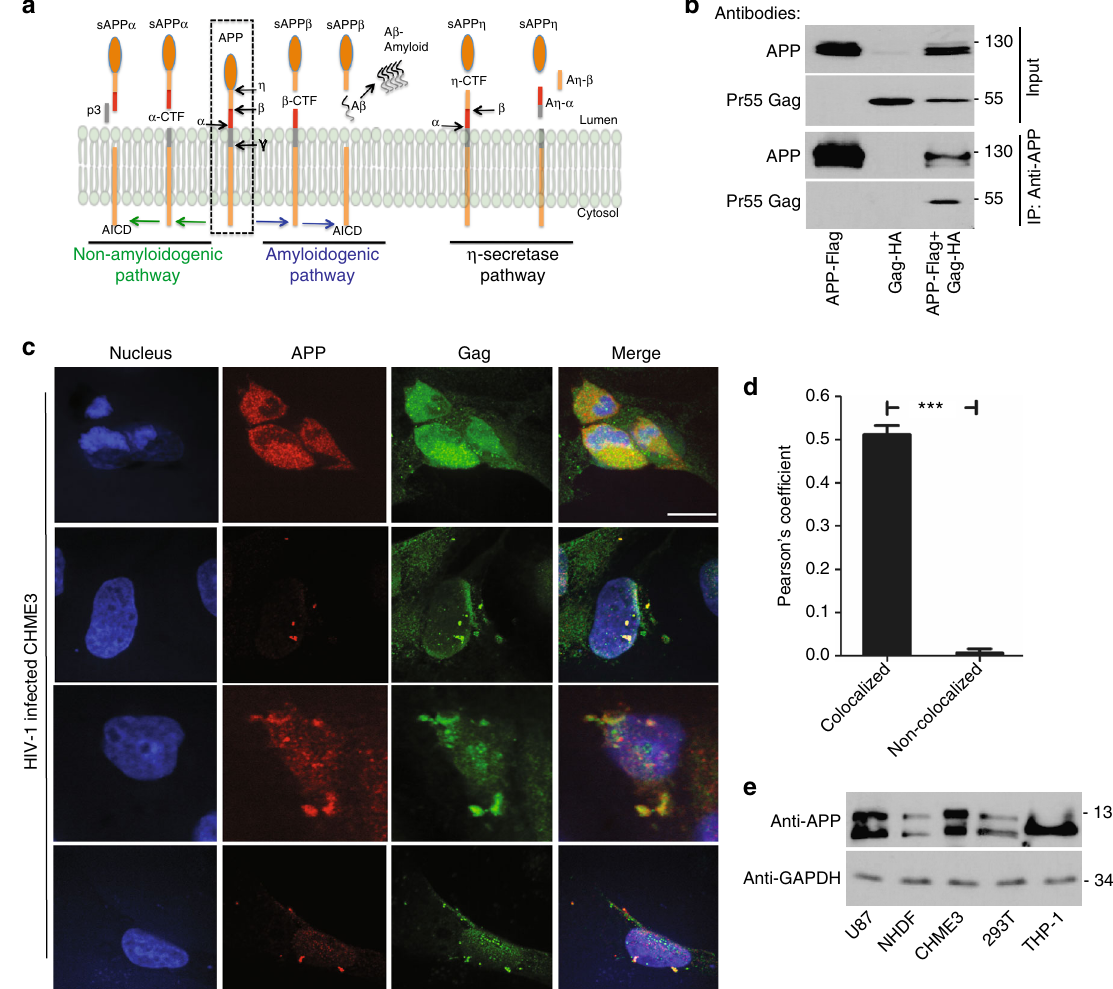
Fig. 1 APP is highly expressed in macrophages and microglia and binds HIV-1 Gag. a APP processing through amyloidogenic, non-amyloidogenic and η - secretase pathways involves α -, β -, γ - and η -secretases. The A β peptide resulting in toxic amyloid oligomers and plaques is generated by sequential cleavages by β - and γ -secretases via the amyloidogenic pathway (central). b Human APP 770 (APP-Flag) binds HIV-1 Gag (Gag-HA) in anti-APP co-IP from transfected 293T cells. c Endogenous APP and Gag colocalize in CHME3 cells infected with HIV-1 carrying vesicular stomatitis virus G (VSV-G) envelope glycoprotein at 16 h post infection (h.p.i). Nuclei were stained with Hoechst (blue). All images were obtained using a 100× oil objective of a spinning disk confocal microscope. Scale bar = 10 μ m. d Quanti fi cation of APP and Gag as determined by Pearson ’ s coef fi cient in at least 10 random fi elds of view from samples as in c , shown as Mean ± SEM. The Pearson ’ s correlation coef fi cients were r = 0.512 ± 0.02. e Endogenous APP levels in glioblastoma (U87), normal human dermal fi broblasts (NHDF), microglia (CHME3), 293T and differentiated THP-1 cells. Molecular weight markers (in kDa) are shown to